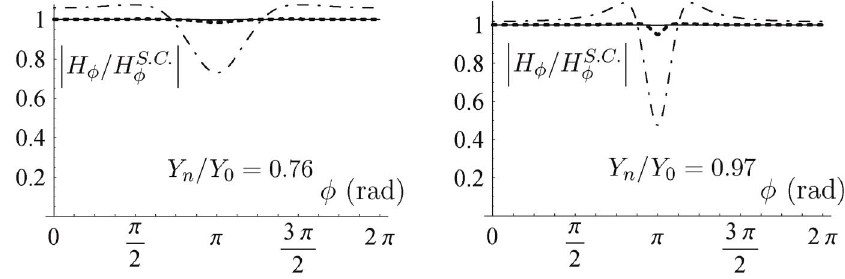
FIG. 2. Azimuthal magnetic field on the boundary ( r (cid:1) b ). The field is plotted at different frequencies: 1 GHz (solid line), 1 MHz (thick dashed line), 1 kHz (dot-dashed line) for two different variations of the conductivity. At the higher frequency the field is more or less constant and the solid lines are hardly visible. Increasing the variation in the conductivity, H decreases, but this is remarkable only at low frequencies. ( b (cid:1) 2 cm , n (cid:1) 1